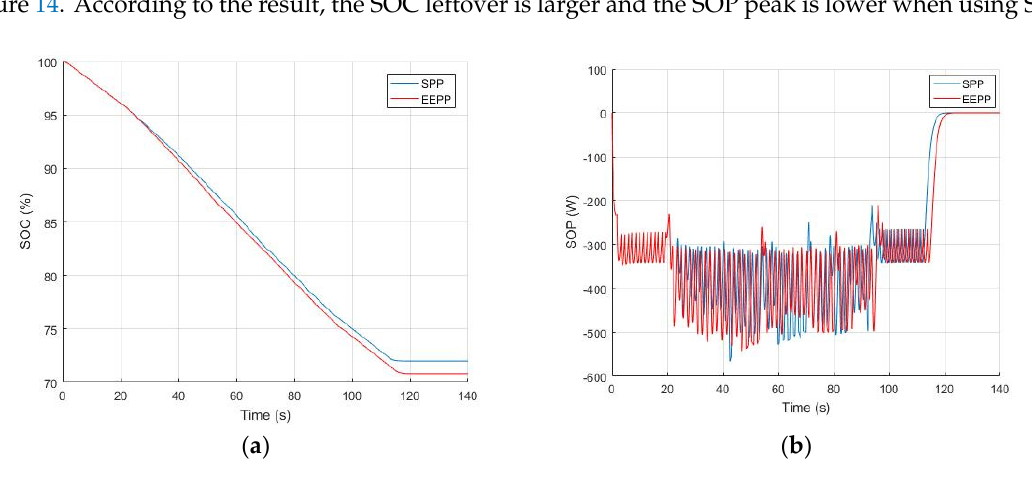
Figure 12. Current and voltage profiles (simulation): ( a ) Current profile and ( b ) voltage profile.